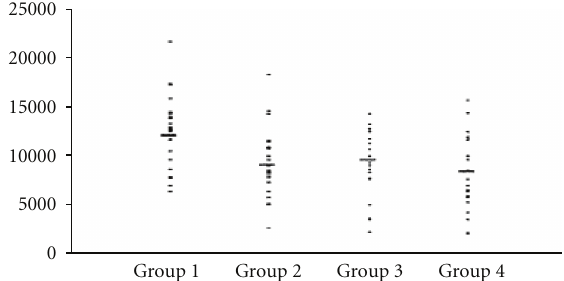
Figure 1: Graph representing area of thrombus along y axis ( μ 2 /mm) Group 1: T2DM with CAD; Group 2: T2DM without clinical macrovascular disease; Group 3: CAD without DM; Group 4: Healthy Controls. Adapted from